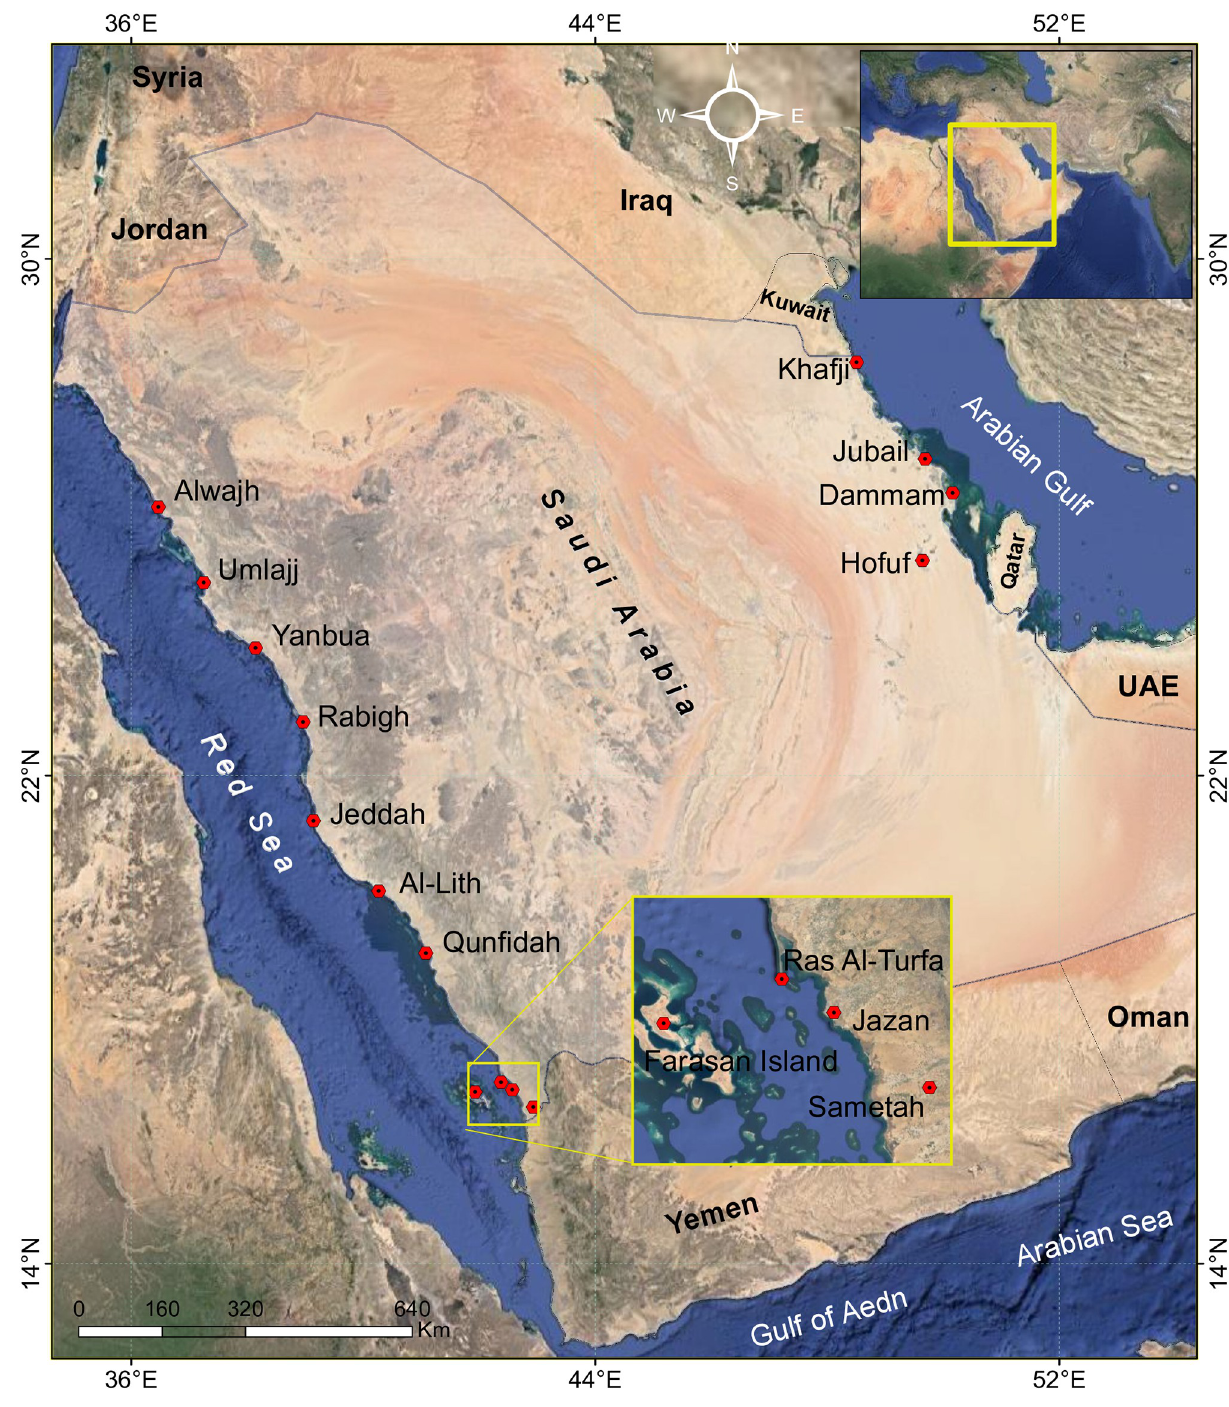
Fig 1. Location map of the study area (The map is modified from Google maps).